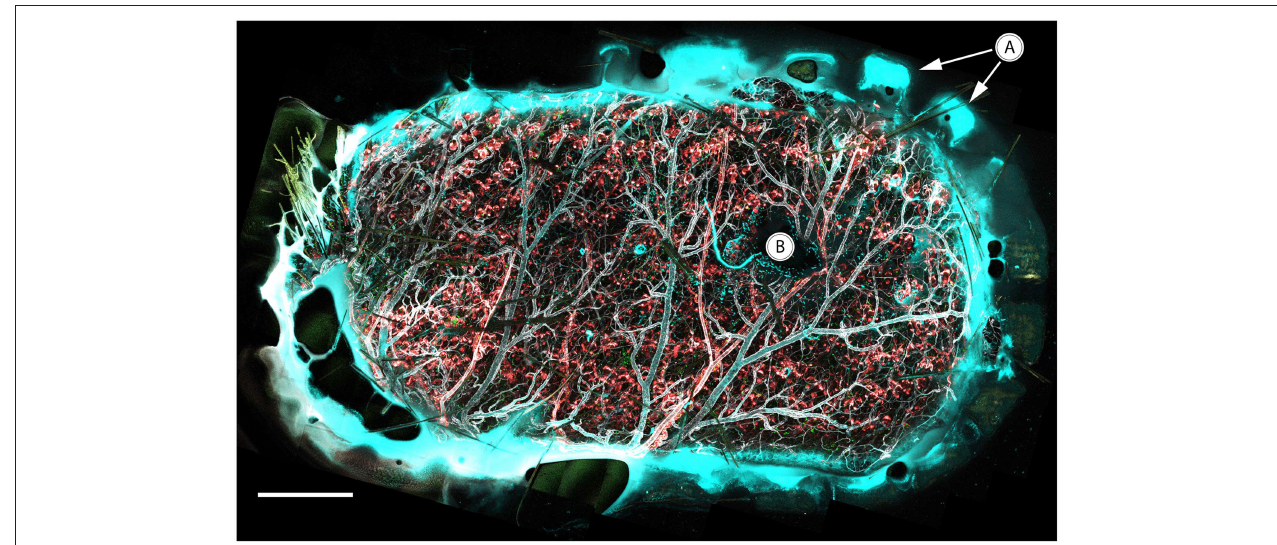
FIGURE 8 | In vivo confocal tile scan of the complete vacuum window opening attached to immunostained mouse skin. (A) Teeth of the window border lining the tissue, (B) MIP-2 gel positioned between the coverslip and underlying tissue. Color code: Ly6G–cyan, CX 3 CR1–green, CD31–gray, NG2–red. Scale bar is 400 µ